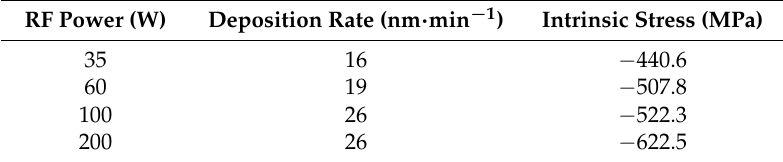
Table 2. Influence of RF power with the intrinsic stress level and deposition rate.